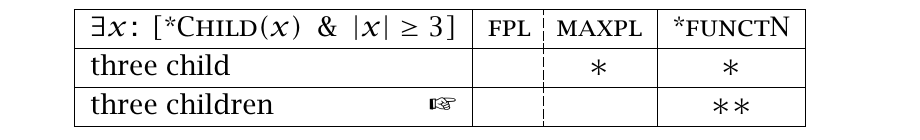
Tableau 4 expressive optimization for plural cardinal meaning (English) grammar of Hungarian has the ranking Fpl (cid:29) *FunctN (cid:29) Maxpl , whereas English exemplifies the grammar {Fpl, Maxpl} (cid:29) *FunctN . For